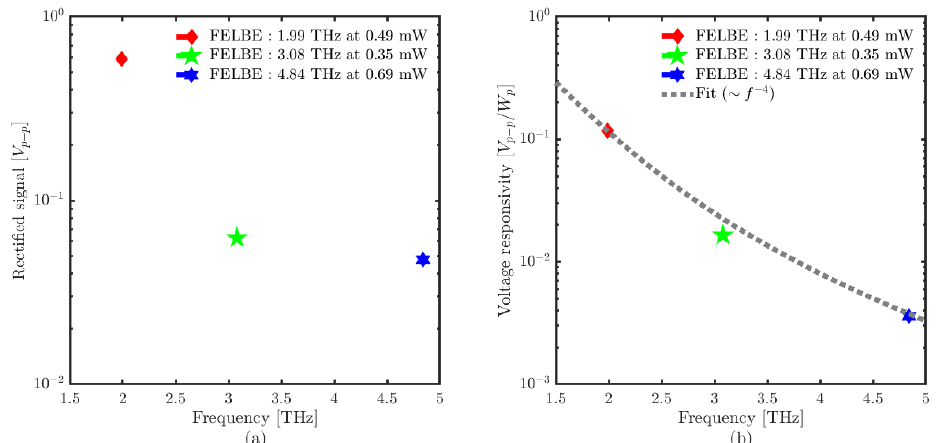
Figure 8. ( a ) Peak–peak rectified voltage; ( b ) voltage responsivity of SD THz detector with FEL using the oscilloscope measurement technique.